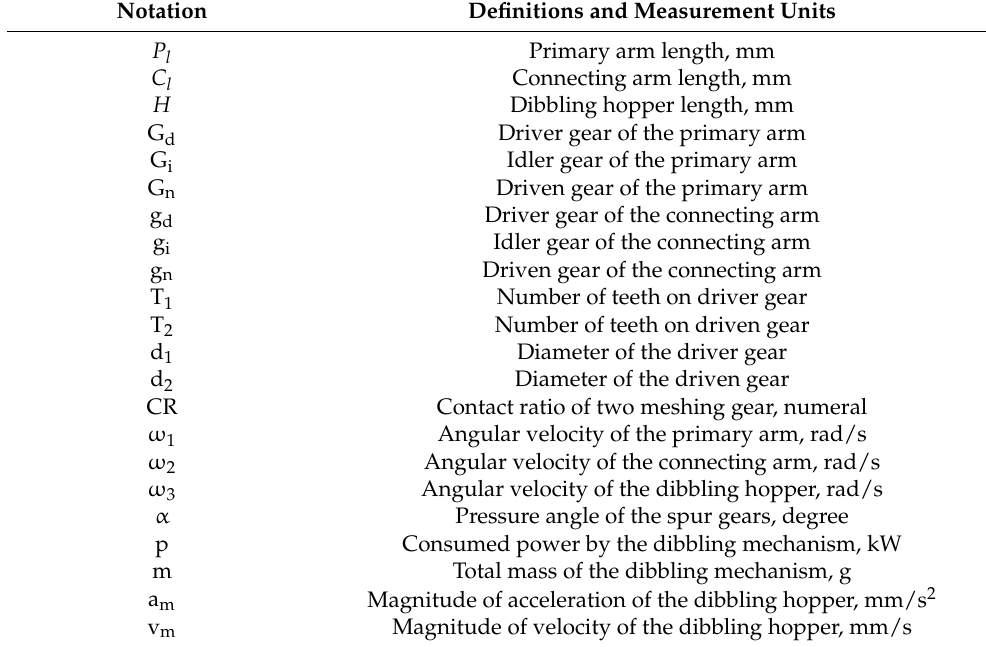
Table 1. Variable notations, definitions, and measurement